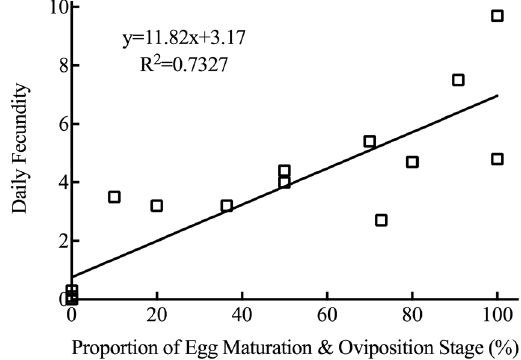
Figure 7. Linear regression model shows that the expectation of daily fecundity is linear to the variable proportion of OFM females in the egg maturation & oviposition